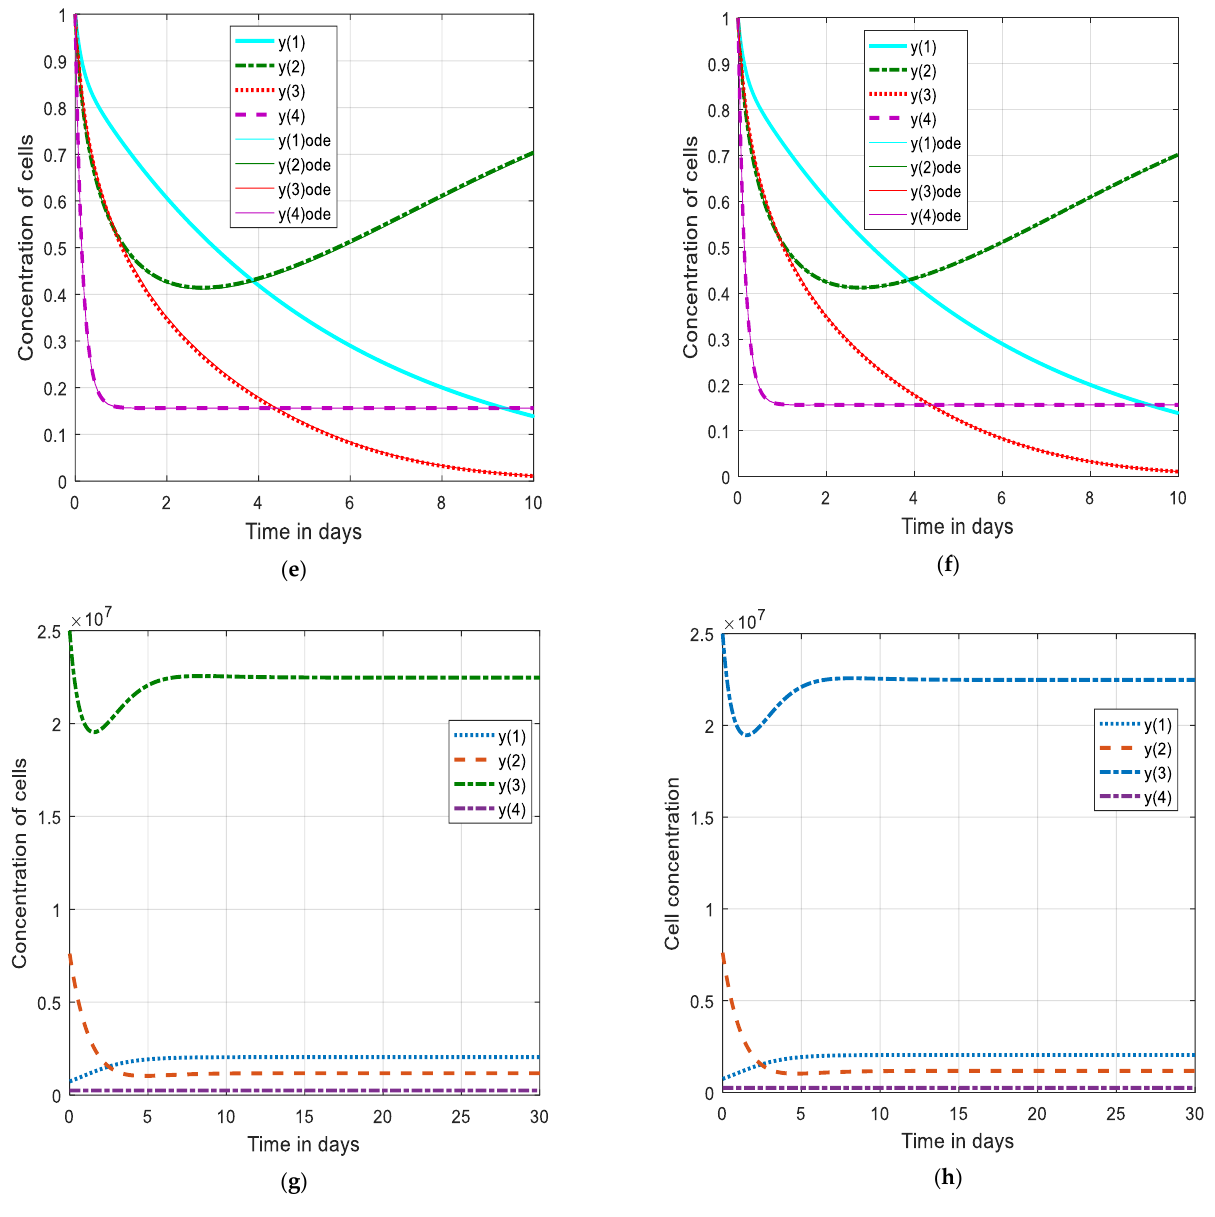
Figure 5. Rate of concentration of cells and drug along the time t in days, y